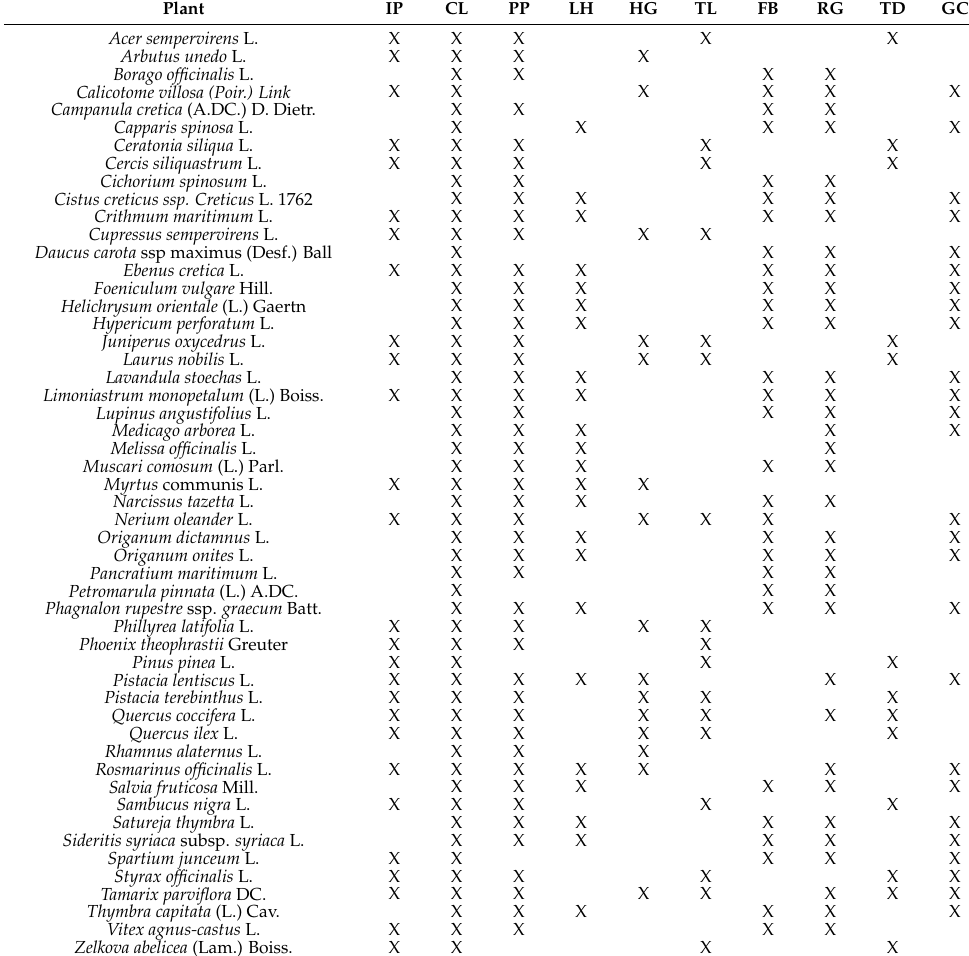
Table 1. Suggested use and function of native Mediterranean plants in landscape architecture. IP: individual planting; CL: group or cluster planting; PP: pot plant; LH: low hedge; HG: